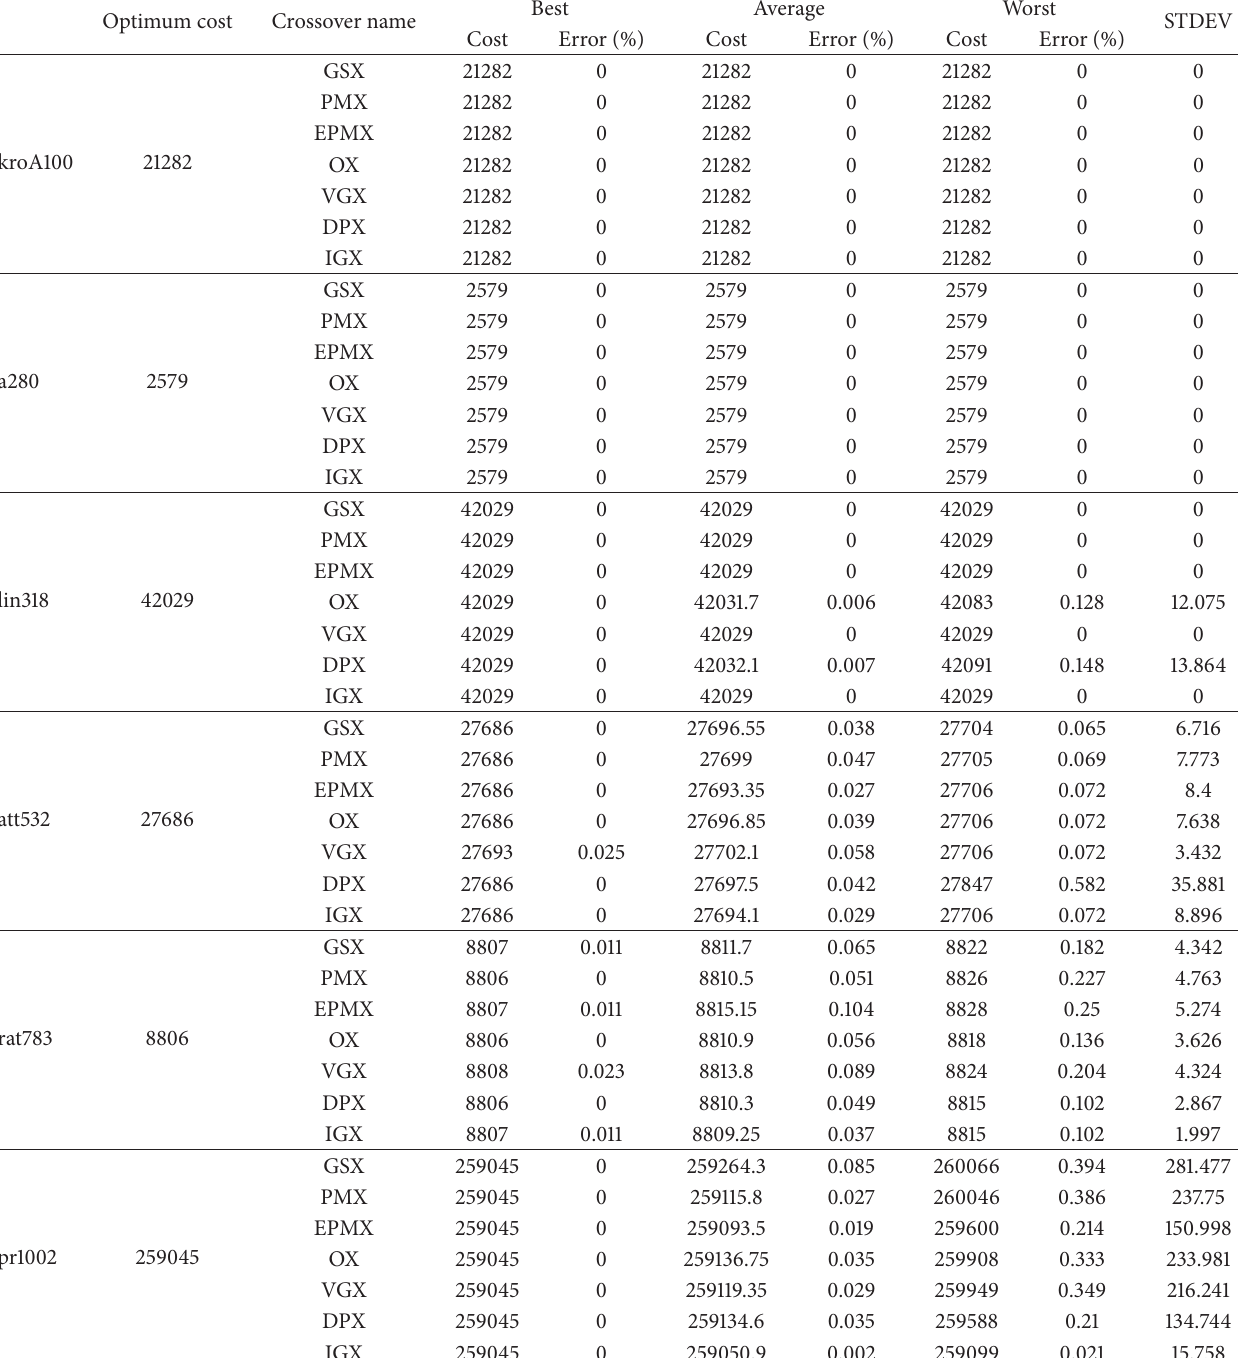
Table 4: Crossovers performance analysis on solution